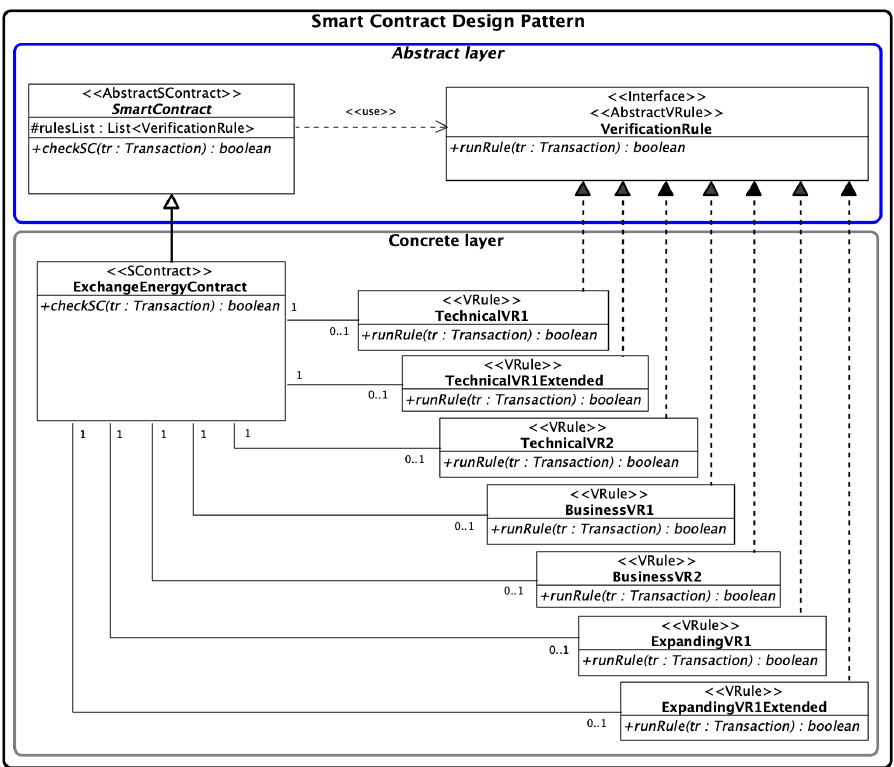
Figure 5. The structure of the pattern in the UML class